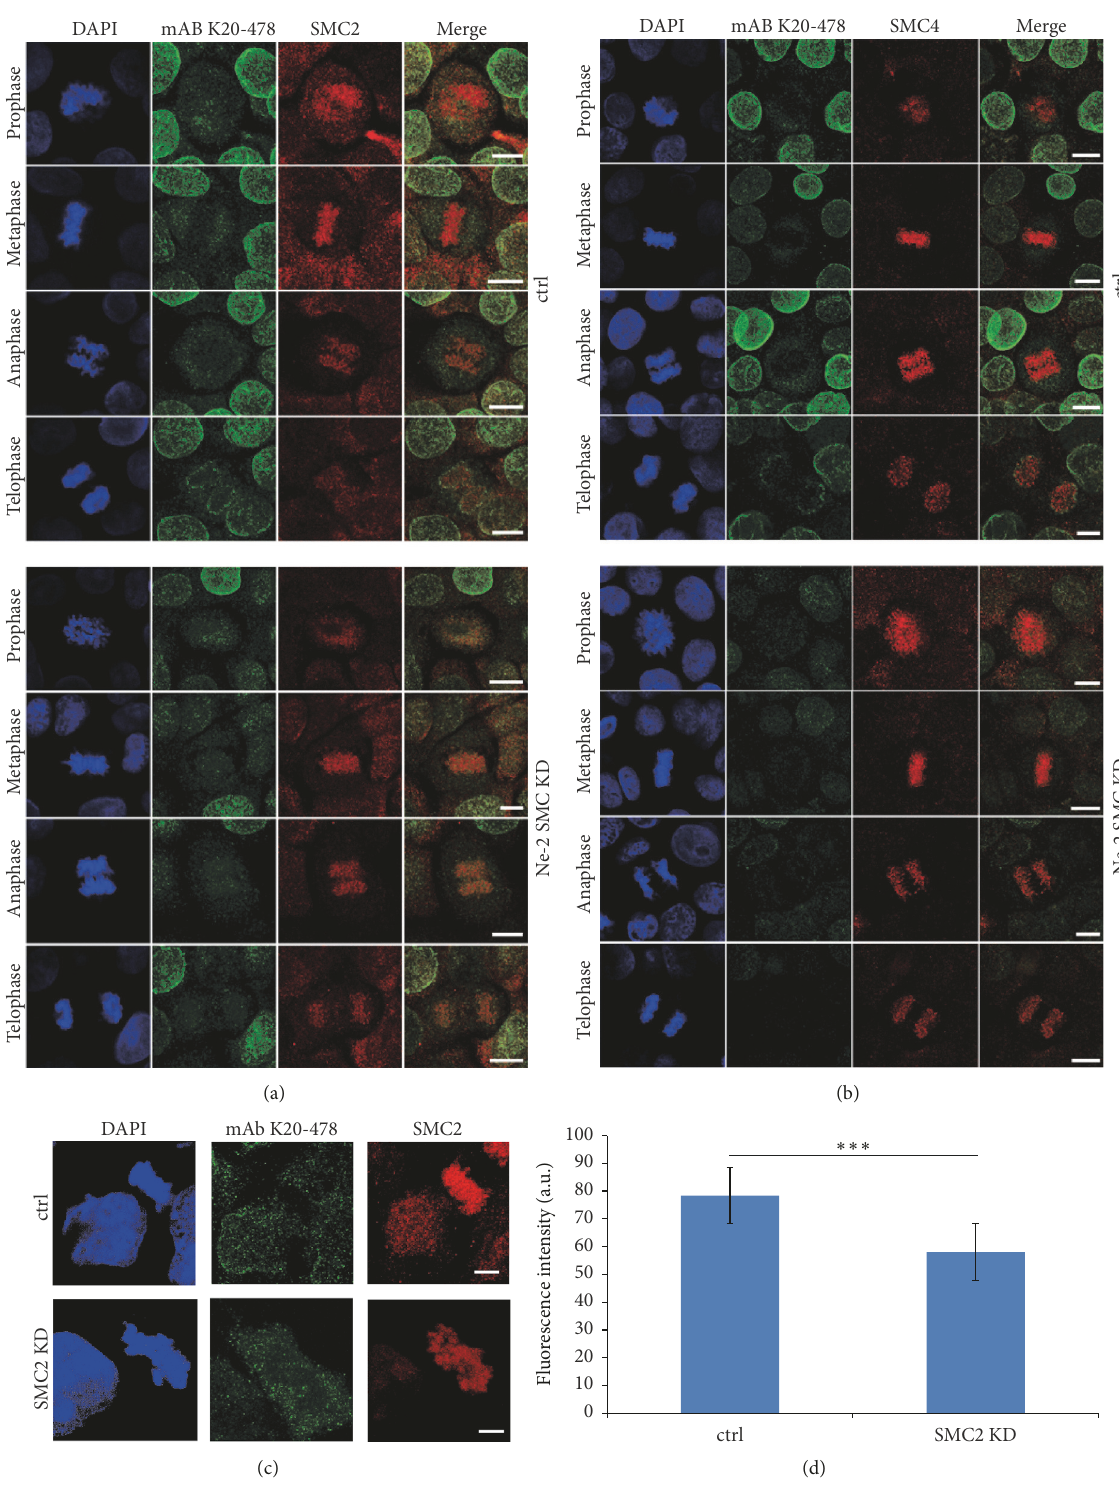
Figure 5: SMC2 (a) and SMC4 (b) in HaCaT keratinocytes treated with control shRNA (upper panels) and treated with Nesprin-2-SMC domain specific shRNA (lower panels). Nesprin-2 was detected with mAb K20-478. Bar, 10 𝜇 m. (c) Localization of Nesprin-2 after siRNA mediated knockdown of SMC2 in COS7 cells. Staining was with SMC2 specific antibodies and mAb K20-478 for Nesprin-2. Bar, 5 𝜇 m. (d) Evaluation of the SMC2 knockdown. SMC2 fluorescence intensity was measured in the center of mitotic chromosomes. 10 siRNA treated cells and 12 control cells (control treatment) were analyzed ( ∗∗∗ 𝑃 value =